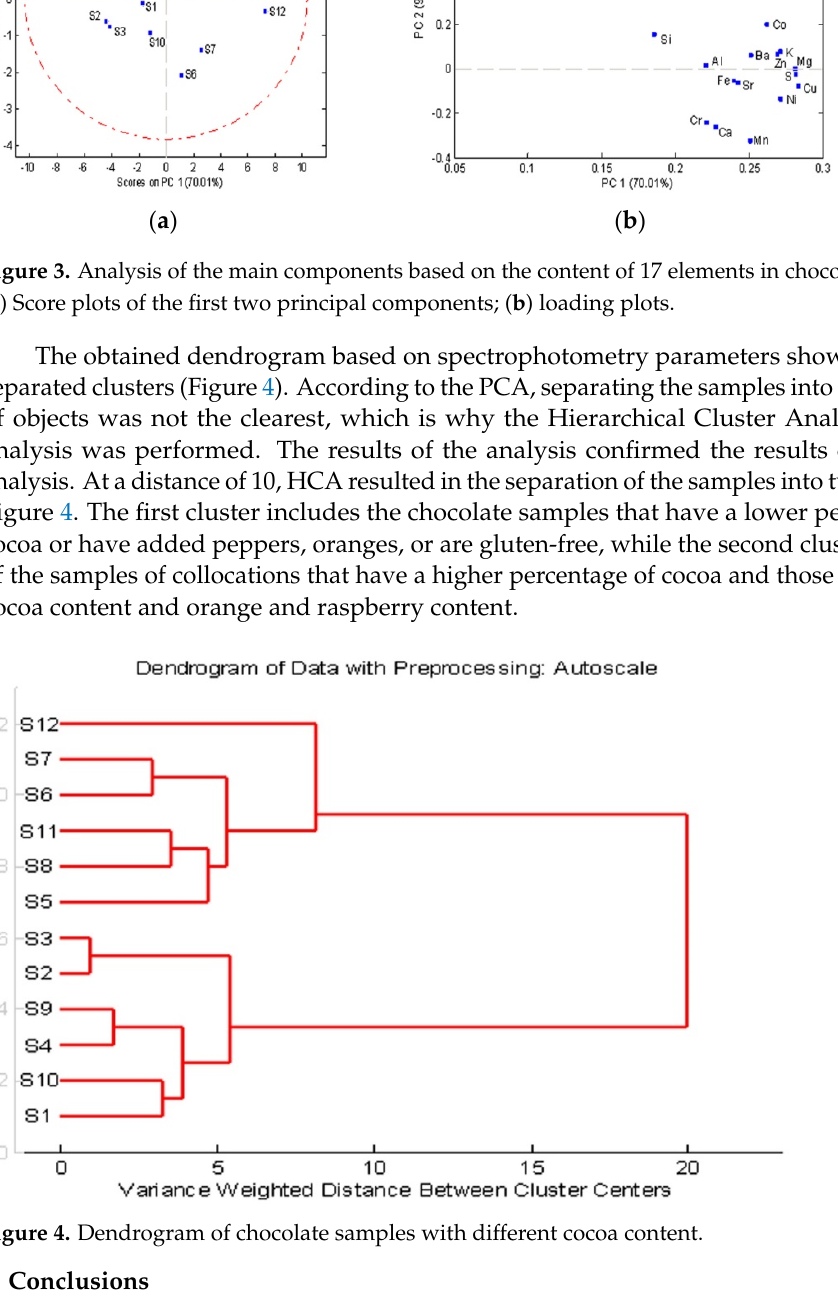
Figure 3. Analysis of the main components based on the content of 17 elements in chocolate samples; ( a ) Score plots of the first two principal components; ( b ) loading plots.